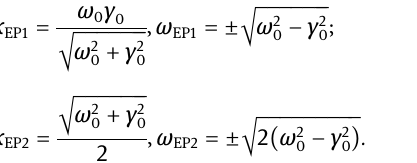
√ and one second-order EP when ω 2 + γ 2 0 0 and a second-order and one second-